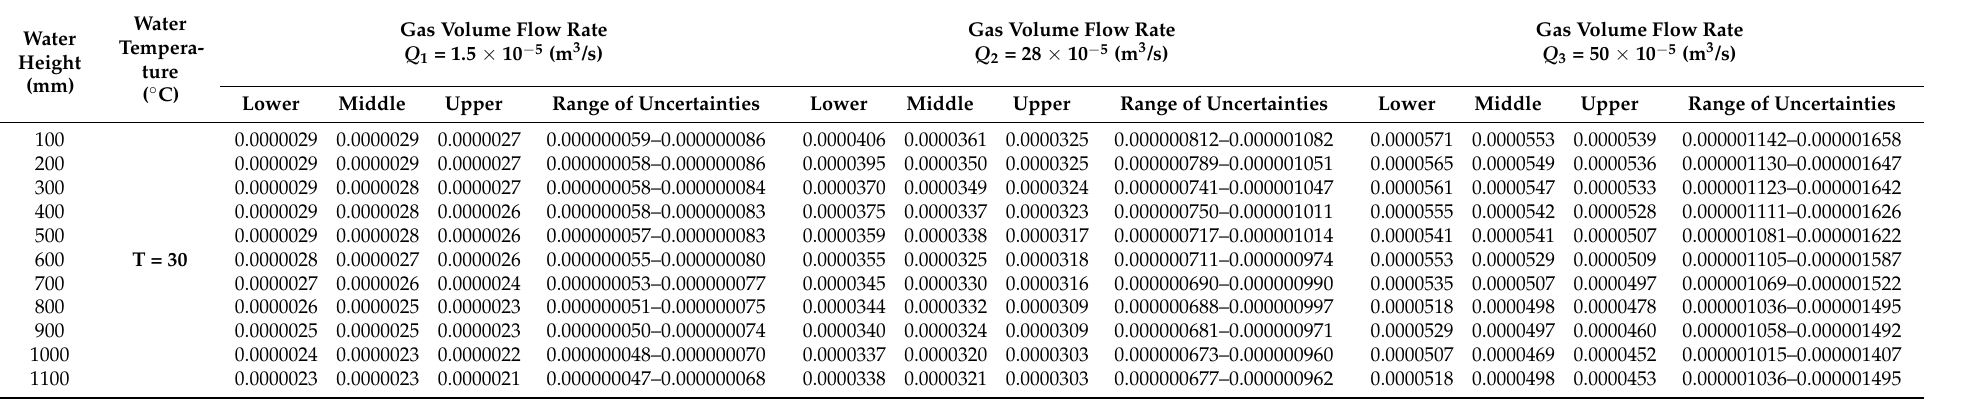
Table 11. Void fraction α as a function of water height for a water temperature of 30 ◦ C and for gas volume flow rates Q 1 –Q 3